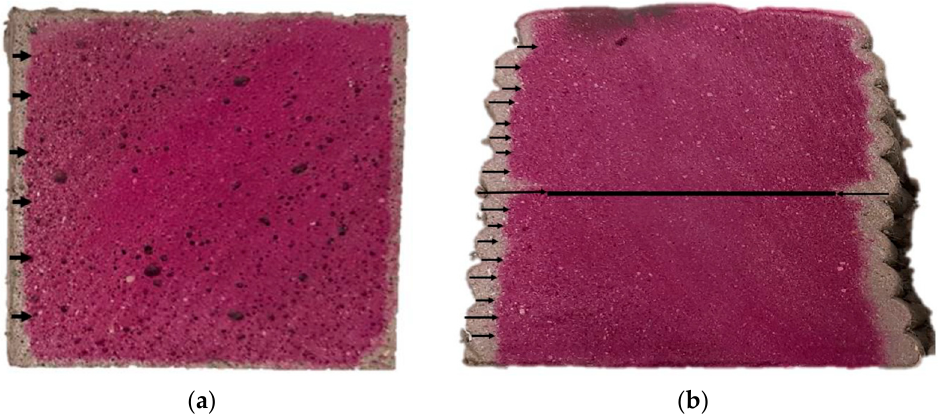
Figure 6. Carbonation depth measurement points (black arrows) for the ( a ) cast and ( b ) printed samples.